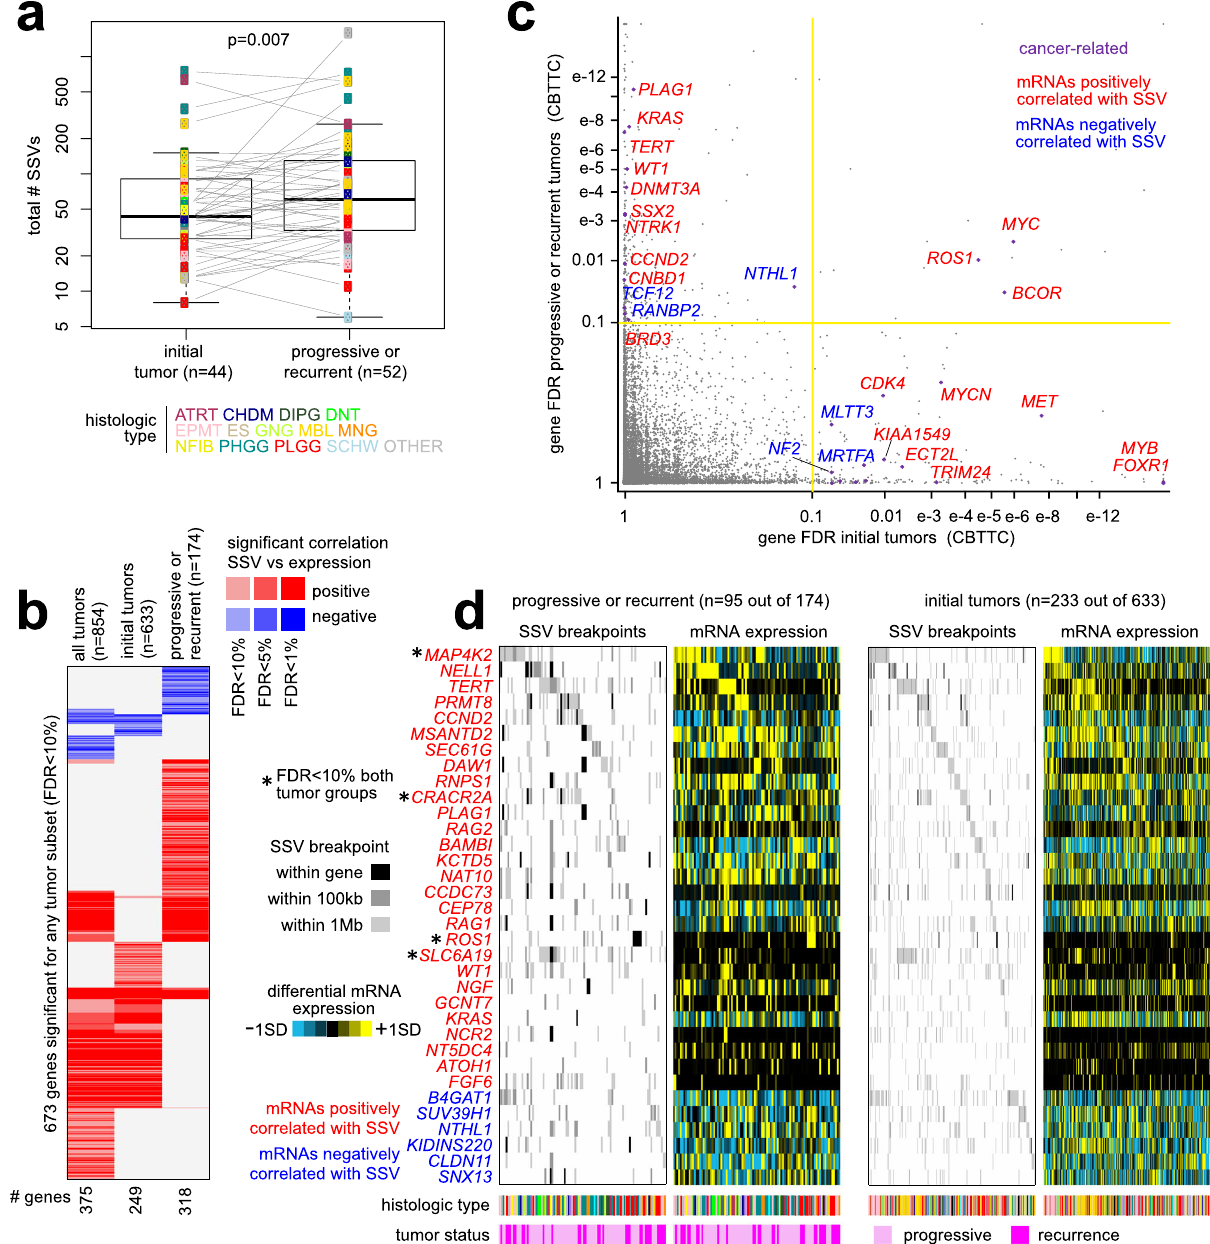
Fig. 6 SSV-impacted genes associated with progressive or recurrent disease. a Signi fi cant differences between initial tumor and recurrent or progressive tumors for total number of SSVs detected, based on a paired analysis involving 44 patients for which both an initial tumor and a recurrent or progressive tumor were pro fi led by WGS. P values by paired t -test on log-transformed data. Box plot represents 5% (lower whisker), 25% (lower box), 50% (median), 75% (upper box), and 95% (upper whisker). b Heat map of signi fi cance patterns for 673 genes signi fi cantly associated with nearby SSV breakpoints (FDR < 10%) for any one of three groups of tumors from CBTTC cohort: (1) all tumors ( n = 854), (2) initial tumors ( n = 633), and (3) recurrent or progressive tumors ( n = 174). Signi fi cance by 1 Mb region window and distance metric method 4 (correcting for both tumor type and CNA). Red denotes signi fi cant positive correlation; blue, signi fi cant negative correlation. c Signi fi cance of genes in the subset of initial tumors ( n = 633 tumors, x -axis), as compared to their signi fi cance in the subset of progressive or recurrent tumors (174 tumors, y -axis). Genes in the upper left quadrant reached signi fi cance only within the progressive or recurrent tumors. d SSV breakpoint and mRNA expression patterns for a set of 34 genes with both a signi fi cant SSV-expression association in the subset of progressive or recurrent tumors ( b ) and with signi fi cant enrichment within progressive or recurrent tumors ( p < 0.05, one- sided Fisher ’ s exact test), as compared to the initial tumors, of SSV breakpoints within 100 kb of the gene. For each of the two tumor subsets represented, the ordering of tumors is the same between the SSV breakpoint and expression matrices. Genes with signi fi cant SSV-gene association for both progressive/recurrent and initial tumor groups are indicated with an asterisk. See ( a ) for tumor type coloring